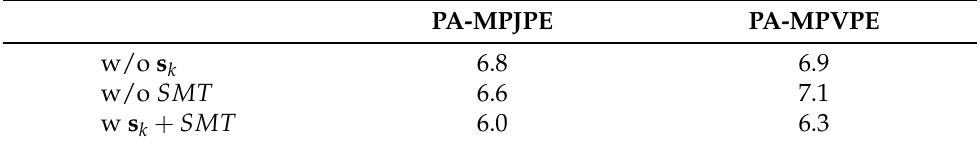
Table 7. FreiHAND dataset: Accuracy results w/o status embedding and SMT.